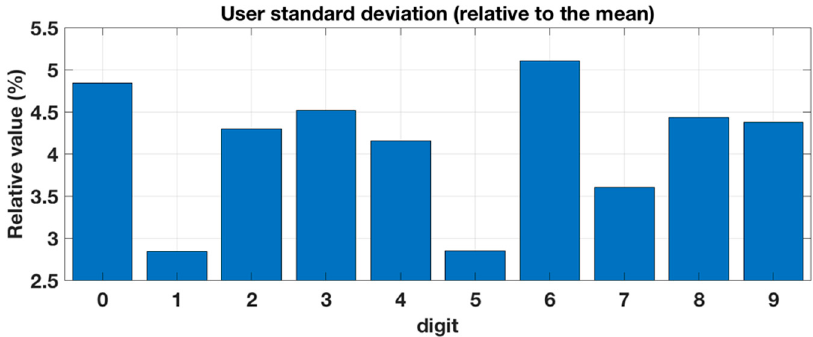
Figure 10. Standard deviation (relative to the mean) between the users for each digit.